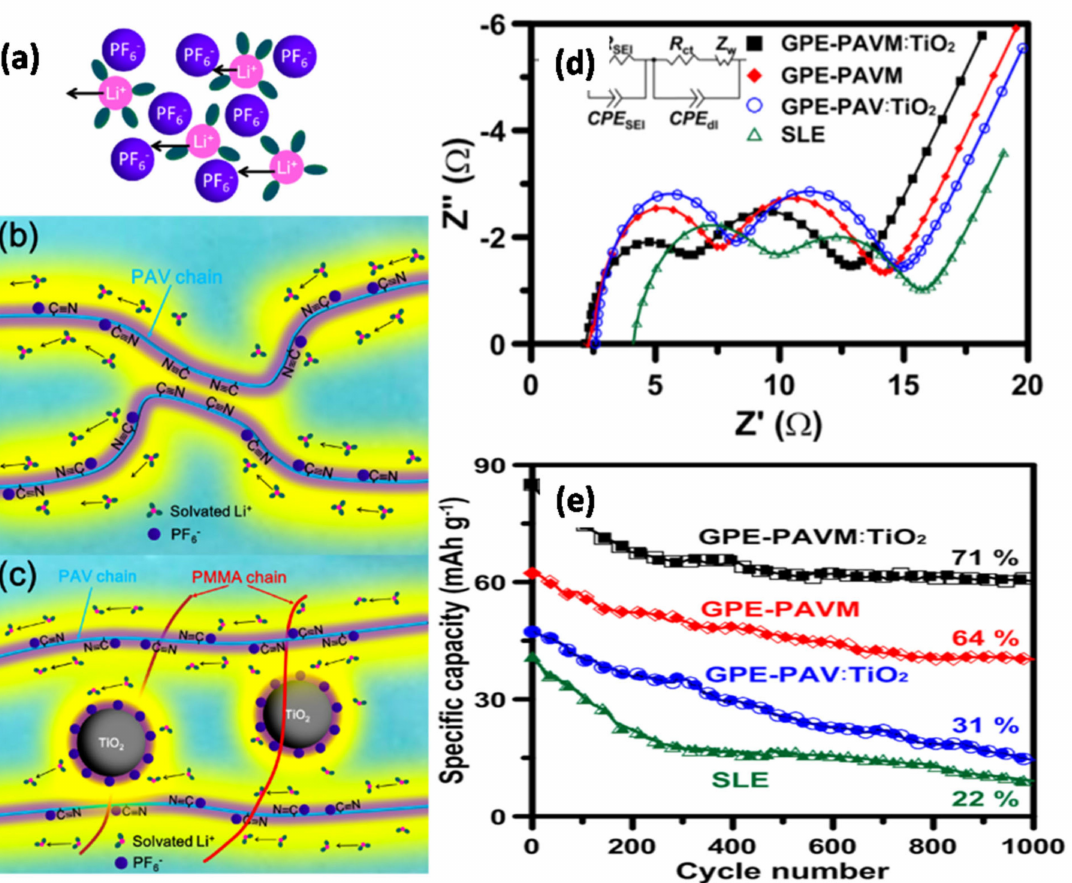
Figure 8. ( a ) Separator-supported LE (SLE): limitation in ionic dissociation. ( b ) GPE- poly(acrylonitrile-co-vinyl acetate) (PAV): a space-charge layer of Li + ions is formed due to the PF 6 − anion absorbed by the nitrile functional groups on the PAV chain. ( c ) GPE-PAVM:TiO 2 : the 3D percolation pathway is formed by the space-charged layers surrounding the TiO 2 NPs and PAV chain. ( d ) Nyquist plots of the full cell (graphite-GPE-LFP) and ( e ) discharge capacity of the full cell at a 20 C-rate over a voltage range of 2.0–3.8 V. Reprinted with permission from Teng et al. [90]. Copyright 2016 American Chemical